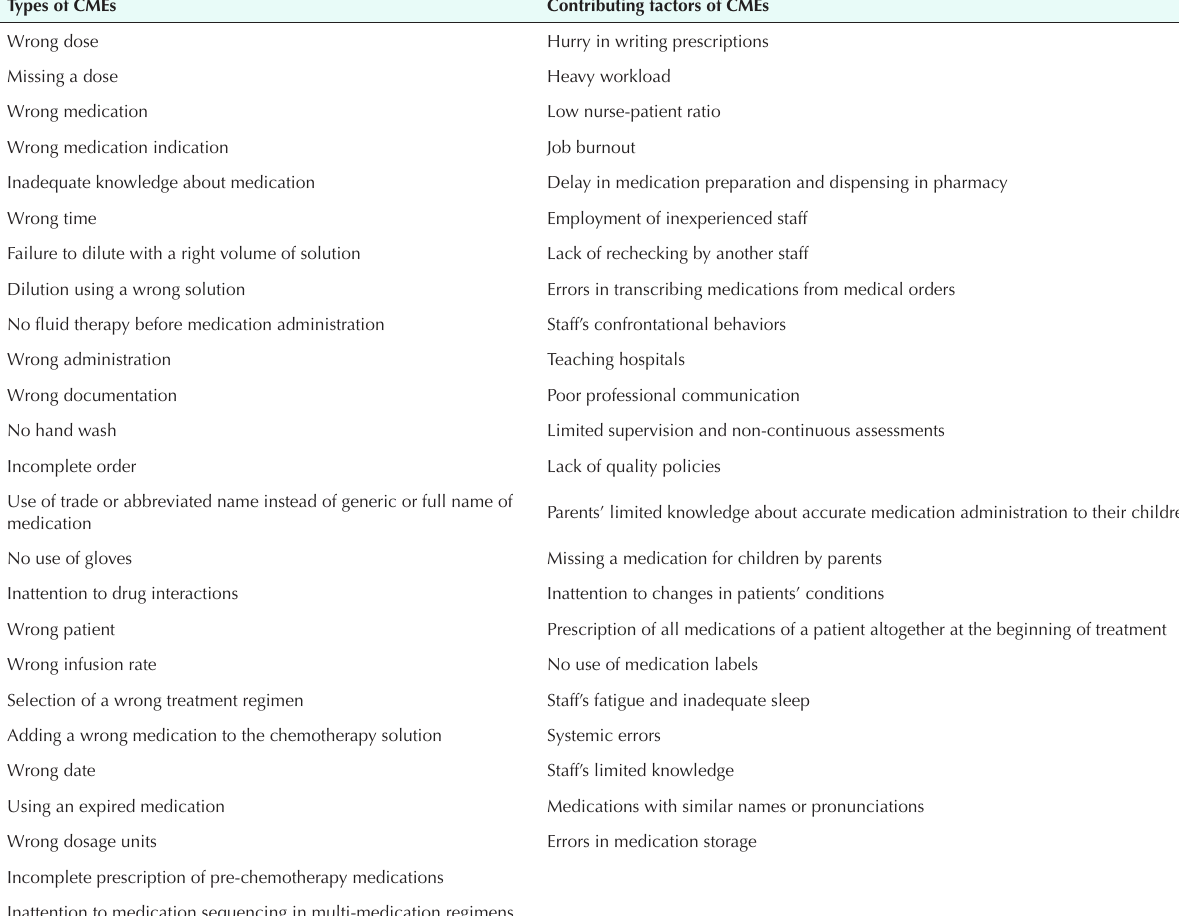
Table 1. Types and contributing factors of errors Types of